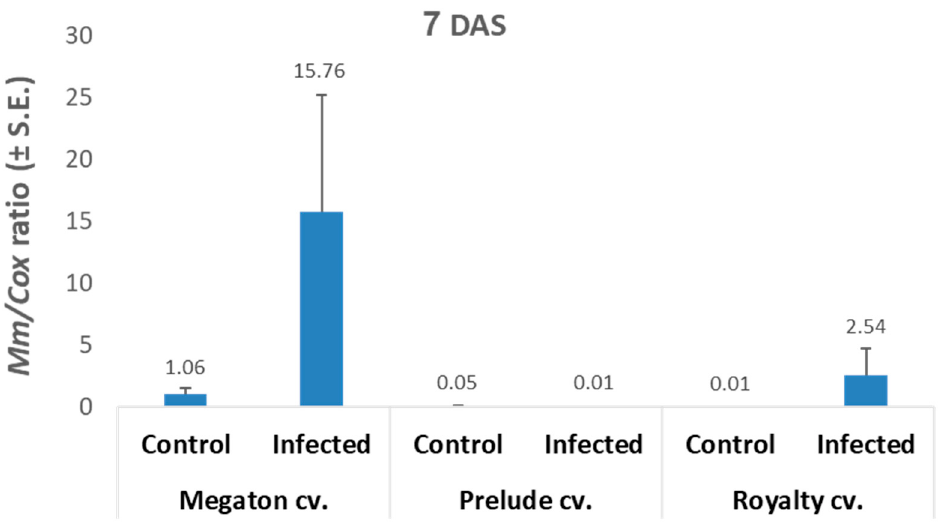
Figure 5. In vitro seed assay, qPCR analysis. The qPCR-based molecular method was used at 7 DAS to identify M. maydis DNA levels in the maize seeds tested in the experiment described in Figure 4. Upper vertical bars represent the standard error of the mean of six replications (representative plants of each cultivar). The target M. maydis -specific DNA was evaluated against a reference “housekeeping” gene—the mitochondria-cytochrome c oxidase, COXI gene.